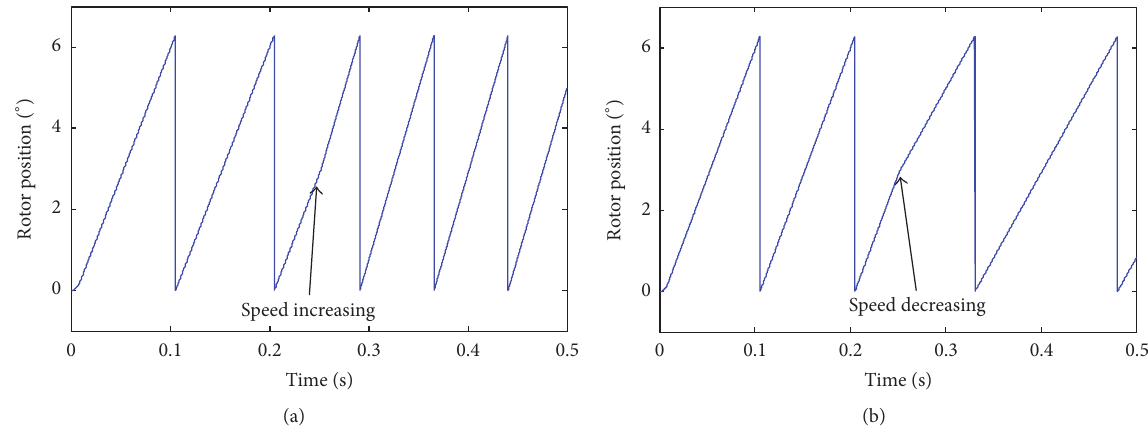
Figure 9: Rotor position angle tracking under changing speed. (a) Speed increasing. (b) Speed decreasing.